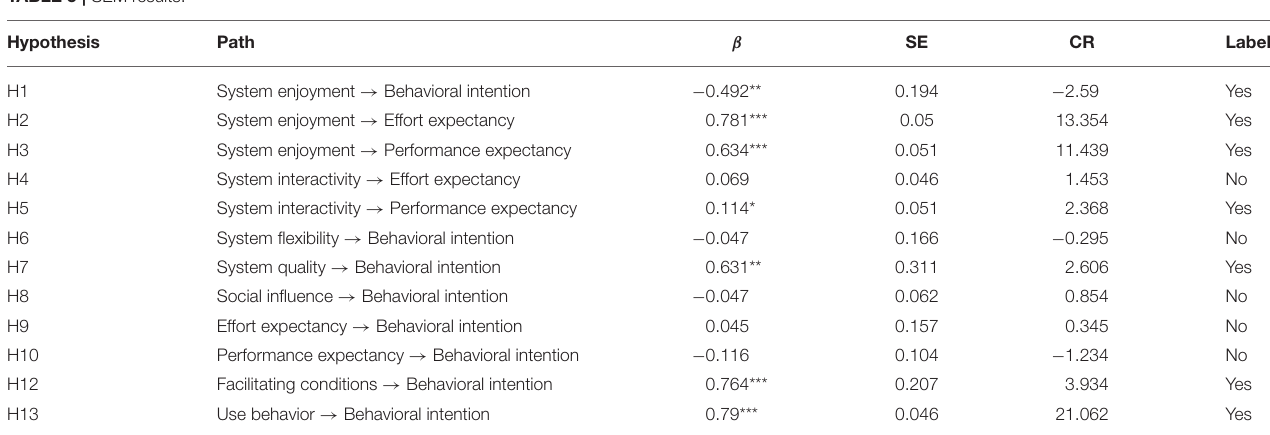
TABLE 5 | SEM results.